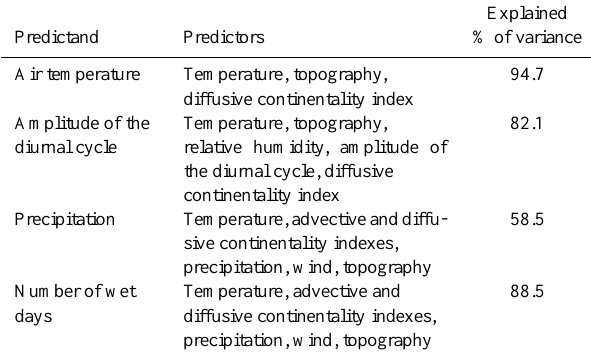
Table 2. List of the predictors selected to perform the downscal- ing of monthly temperature and precipitation variables over south- ern Africa. The predictors “temperature”, “relative humidity”, “am- plitude of the diurnal cycle”, “precipitation” and “wind” are taken from the IPSL_CM5A simulation and interpolated to 0.16 ◦ . The diffusive continentality index corresponds to the shortest distance to the ocean; the advective continentality index depends on both the wind simulated in the GCM and the distance to the ocean. See Lev- avasseur et al. (2011) for a complete description of the construction of these two predictors.